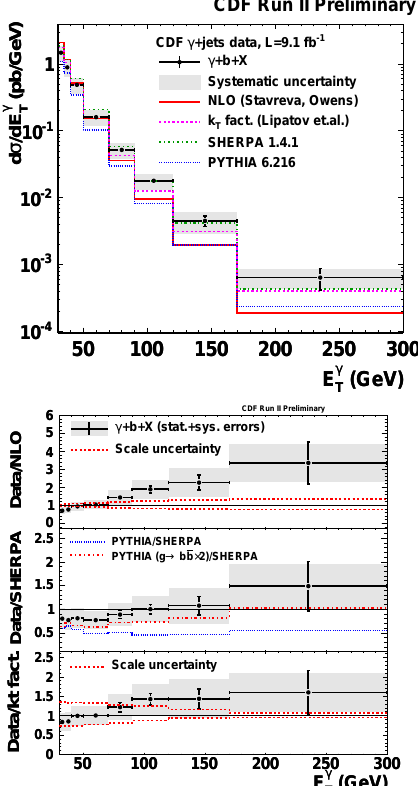
Figure 3. The measured di ff erential cross sections compared with four theoretical predictions. The absolute comparisons are shown in the upper plot and the ratios of data over the theory are shown in the lower plot. The shaded area around the data points indicates total systematic uncertainty of the measurement. Figure 4. The ratio of